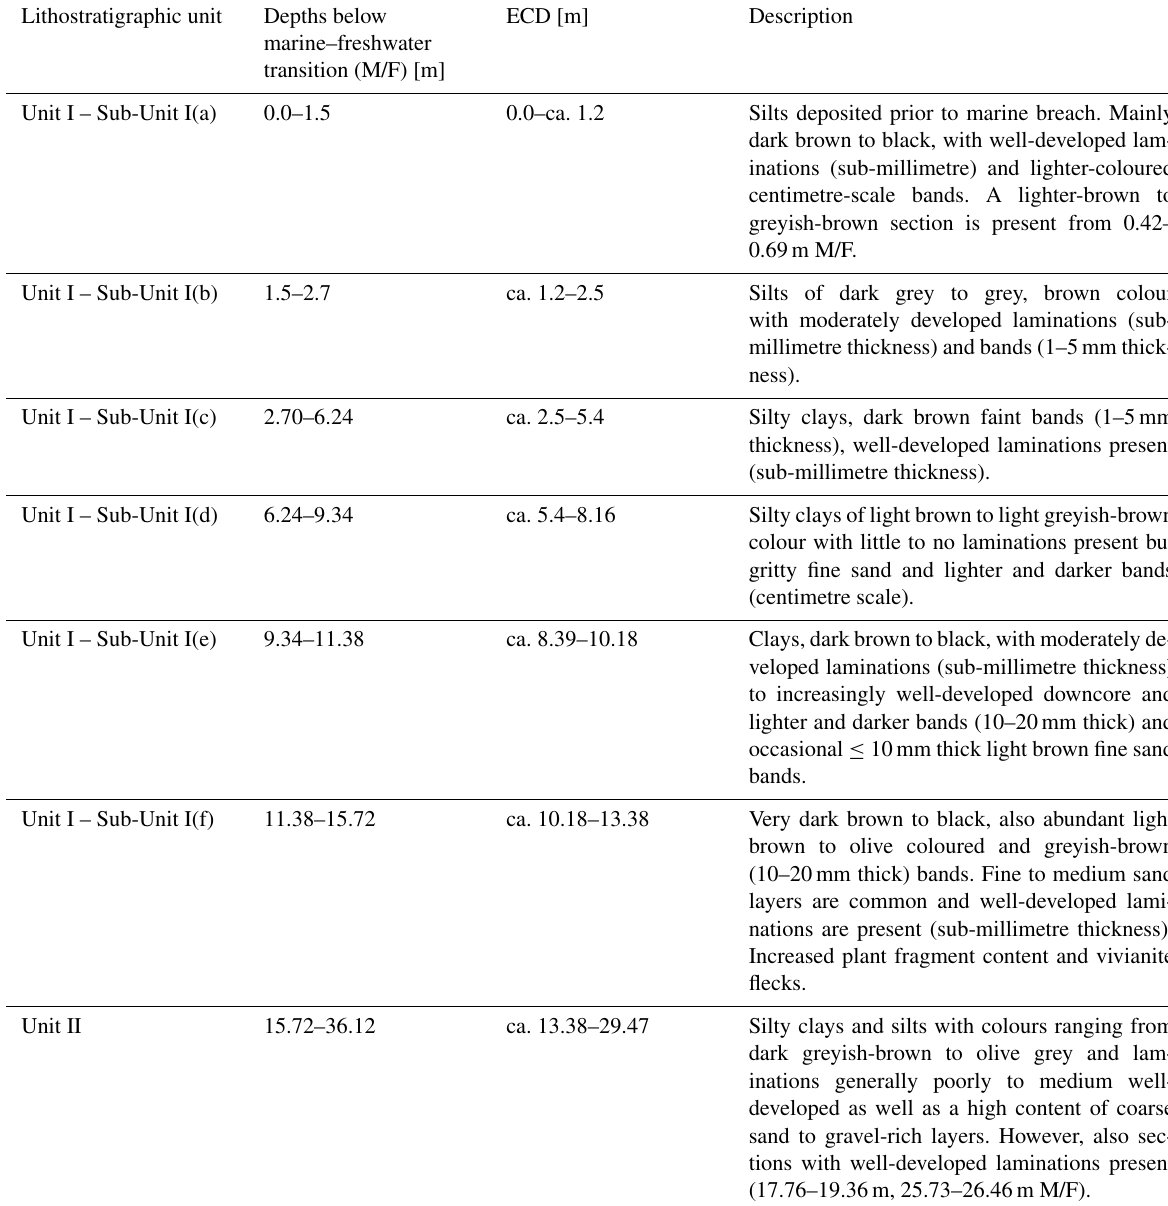
Table 1. Description of the lithostratigraphic units for the 2018 Onepoto composite record based on the naming convention defined by Hägg and Augustinus, 2003. ECD represents event-corrected